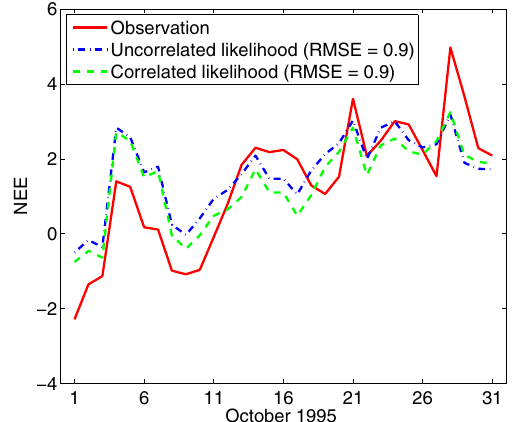
Figure 14. Simulated NEE values based on the MAP estimates from the uncorrelated and correlated Gaussian likelihoods in Oc- tober